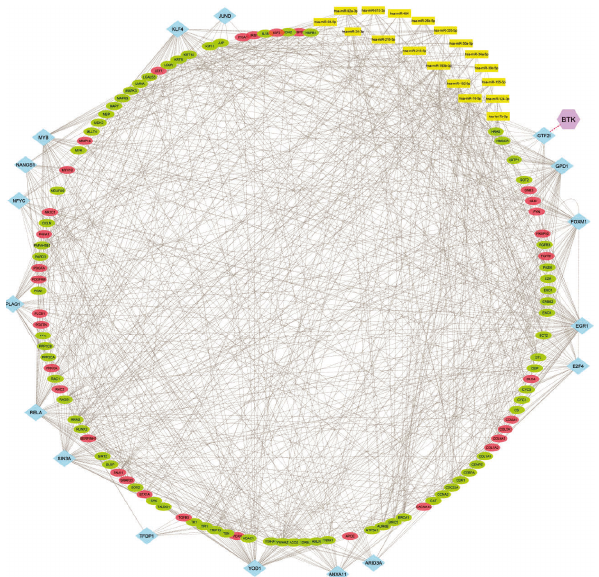
Figure 5: Gene regulatory network. Red and green circles represent up- and downregulated hub genes, respectively. Blue diamonds demonstrate TFs, while yellow rectangles show miRNAs. The violet hexagon illustrates the protein kinase enriched by the TFs. TF, transcription